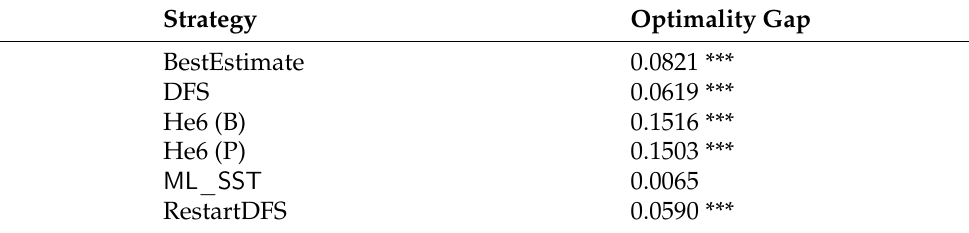
Figure A2. Capacitated facility location: average solving time against the average optimality gap of the first solution found at a leaf node. ‘**’ p < 0.01. Table A4. Capacitated facility location: model with on_both = Second, on_leaf = Score and prune_on_both = True against baselines, with equal time limits for each problem. The initial op- timality gap obtained by the solver before branch-and-bound is 0.325. Pairwise t -tests against the ML policy: ‘***’ p <